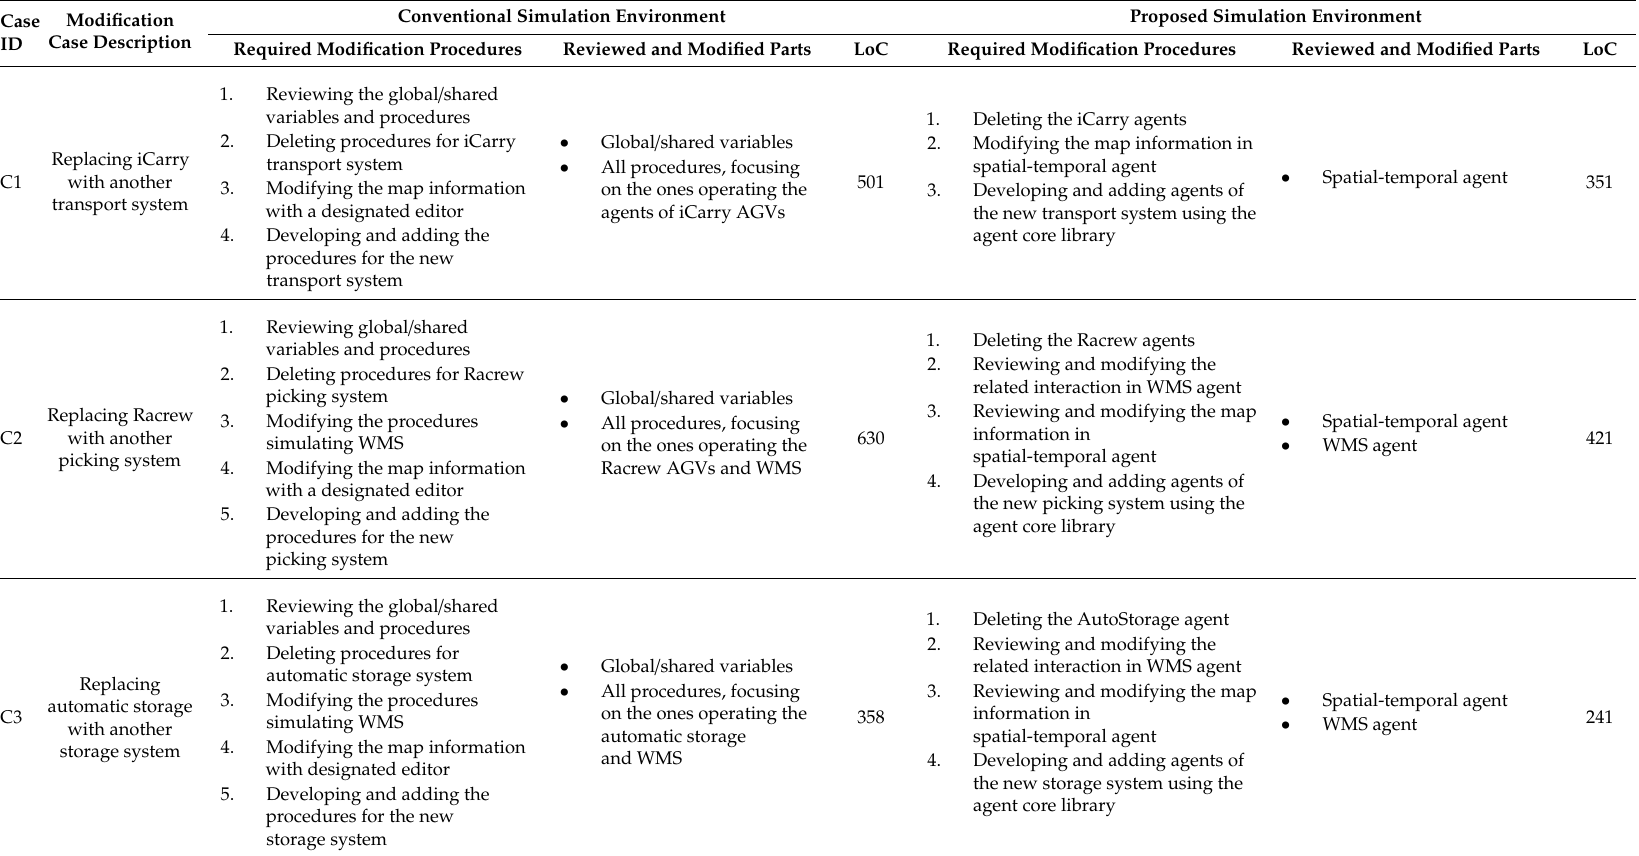
Table 2. Modification cost evaluations on essential modification